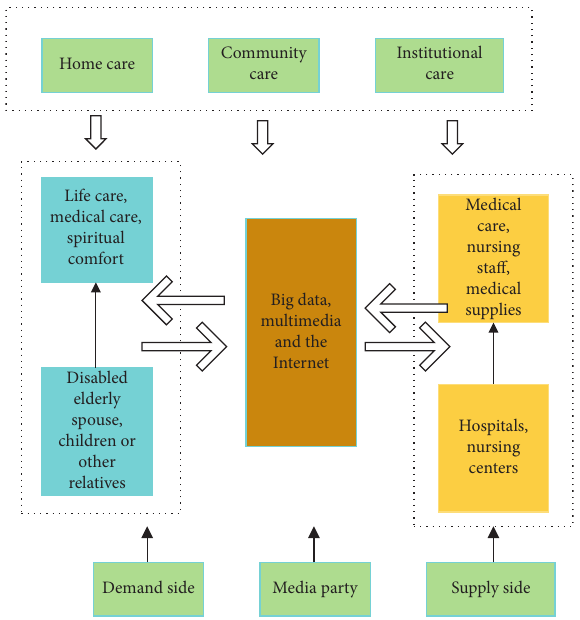
Figure 5: Map of the “Internet+” application model.